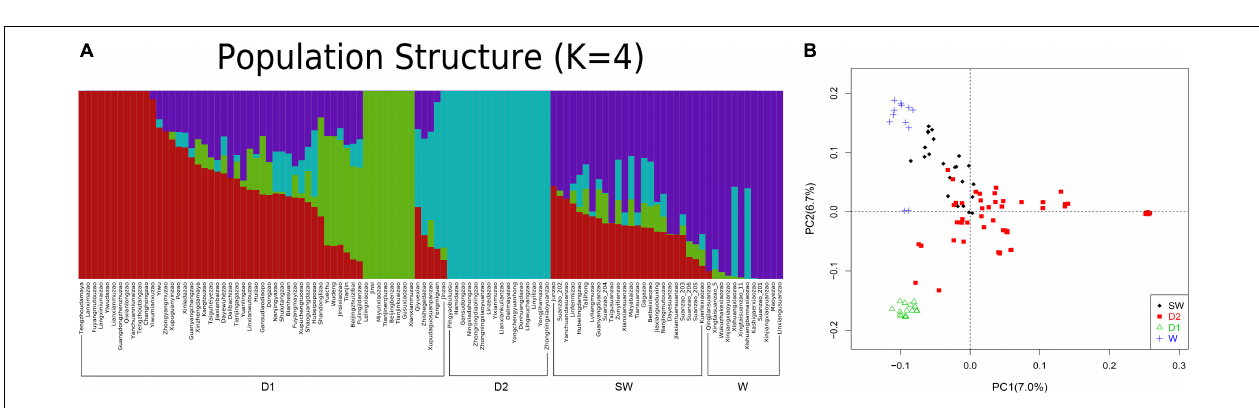
FIGURE 2 | The phylogenetic tree of 23 genomes. Divergence time and proportions of gene families that underwent expansion or contraction are shown in the nodes. Bootstrapping supports (SH-aLRT/UFBoot) are presented along with the 95% CIs for each dating point in brackets.